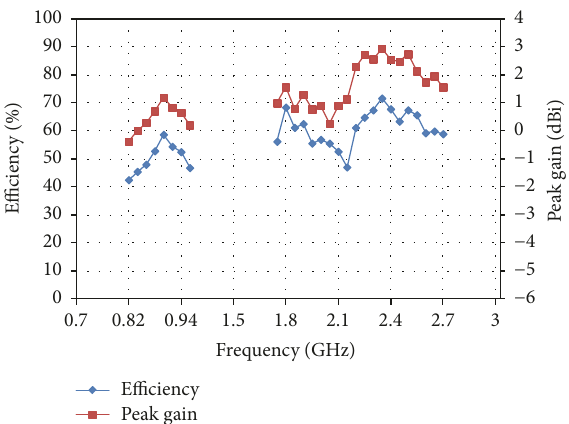
Figure9:Photographofthecommercialsmartmobilephonedevice for the active performance